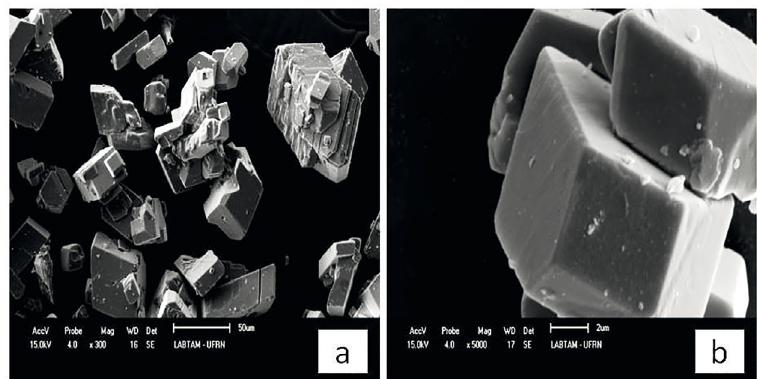
Figure 4. SEM micrograph of APT, (a) 300X and (b)